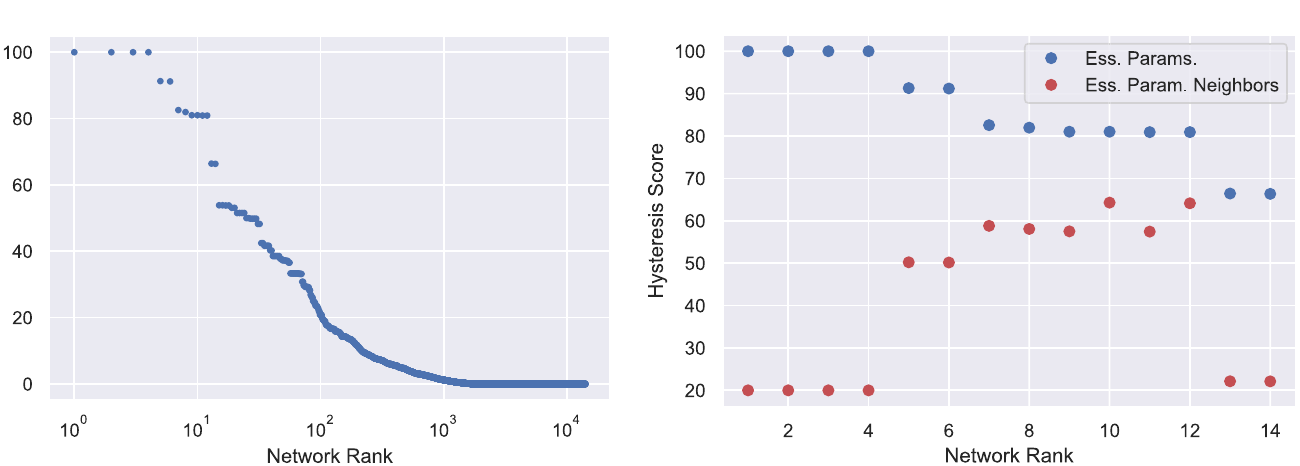
Fig 2. Left: 14,098 three node networks ranked by (ascending) hysteresis score analyzed at the essential parameters. This is the percentage of partial paths in the essential parameter sub-graph which exhibit switch-like behavior. The rapid decrease in score indicates that most networks are unlikely to exhibit hysteresis at most parameters. Right: The top scoring networks are further discriminated by scoring hysteresis in a neighborhood of the essential parameters. The scores after perturbation (red) are significantly lower than the scores at essential parameters (blue) for the top 4 networks. This is an indication that these networks are fragile i.e. will fail to perform well if any component of the network is